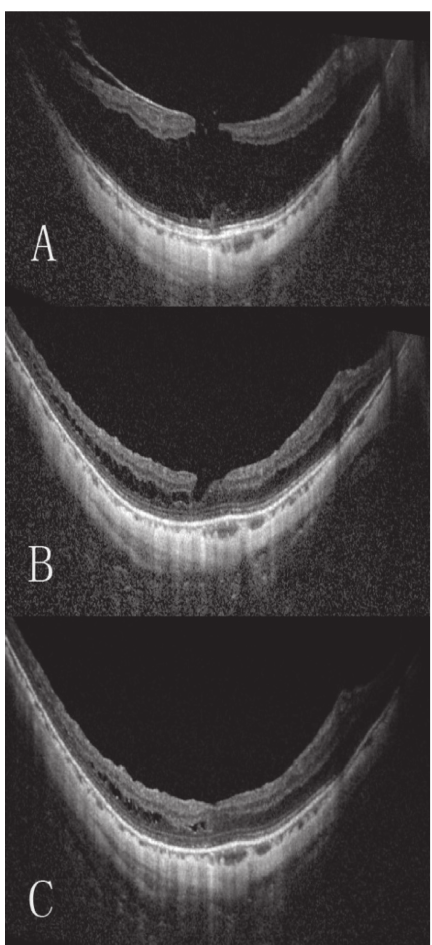
Figure 2: Preoperative and postoperative images for a represen- tative case of highly myopic foveoschisis-associated lamellar macular hole treated by vitrectomy with suitable internal limiting membrane peeling and air tamponade (Case 11). (a) Preoperative optical co- herence tomography (OCT) images reveal foveoschisis and lamellar macular hole. The Snellen vision acuity was 20/60. (b) OCT image obtained at the 3-month follow-up evaluation shows that the macular hole has closed and the retinoschisis has reduced. The Snellen vision acuity was 20/25. (c) OCTimage obtained at the 1-year follow-up evaluation shows a closed macular hole with further re- duction in the retinoschisis. The final Snellen vision acuity was